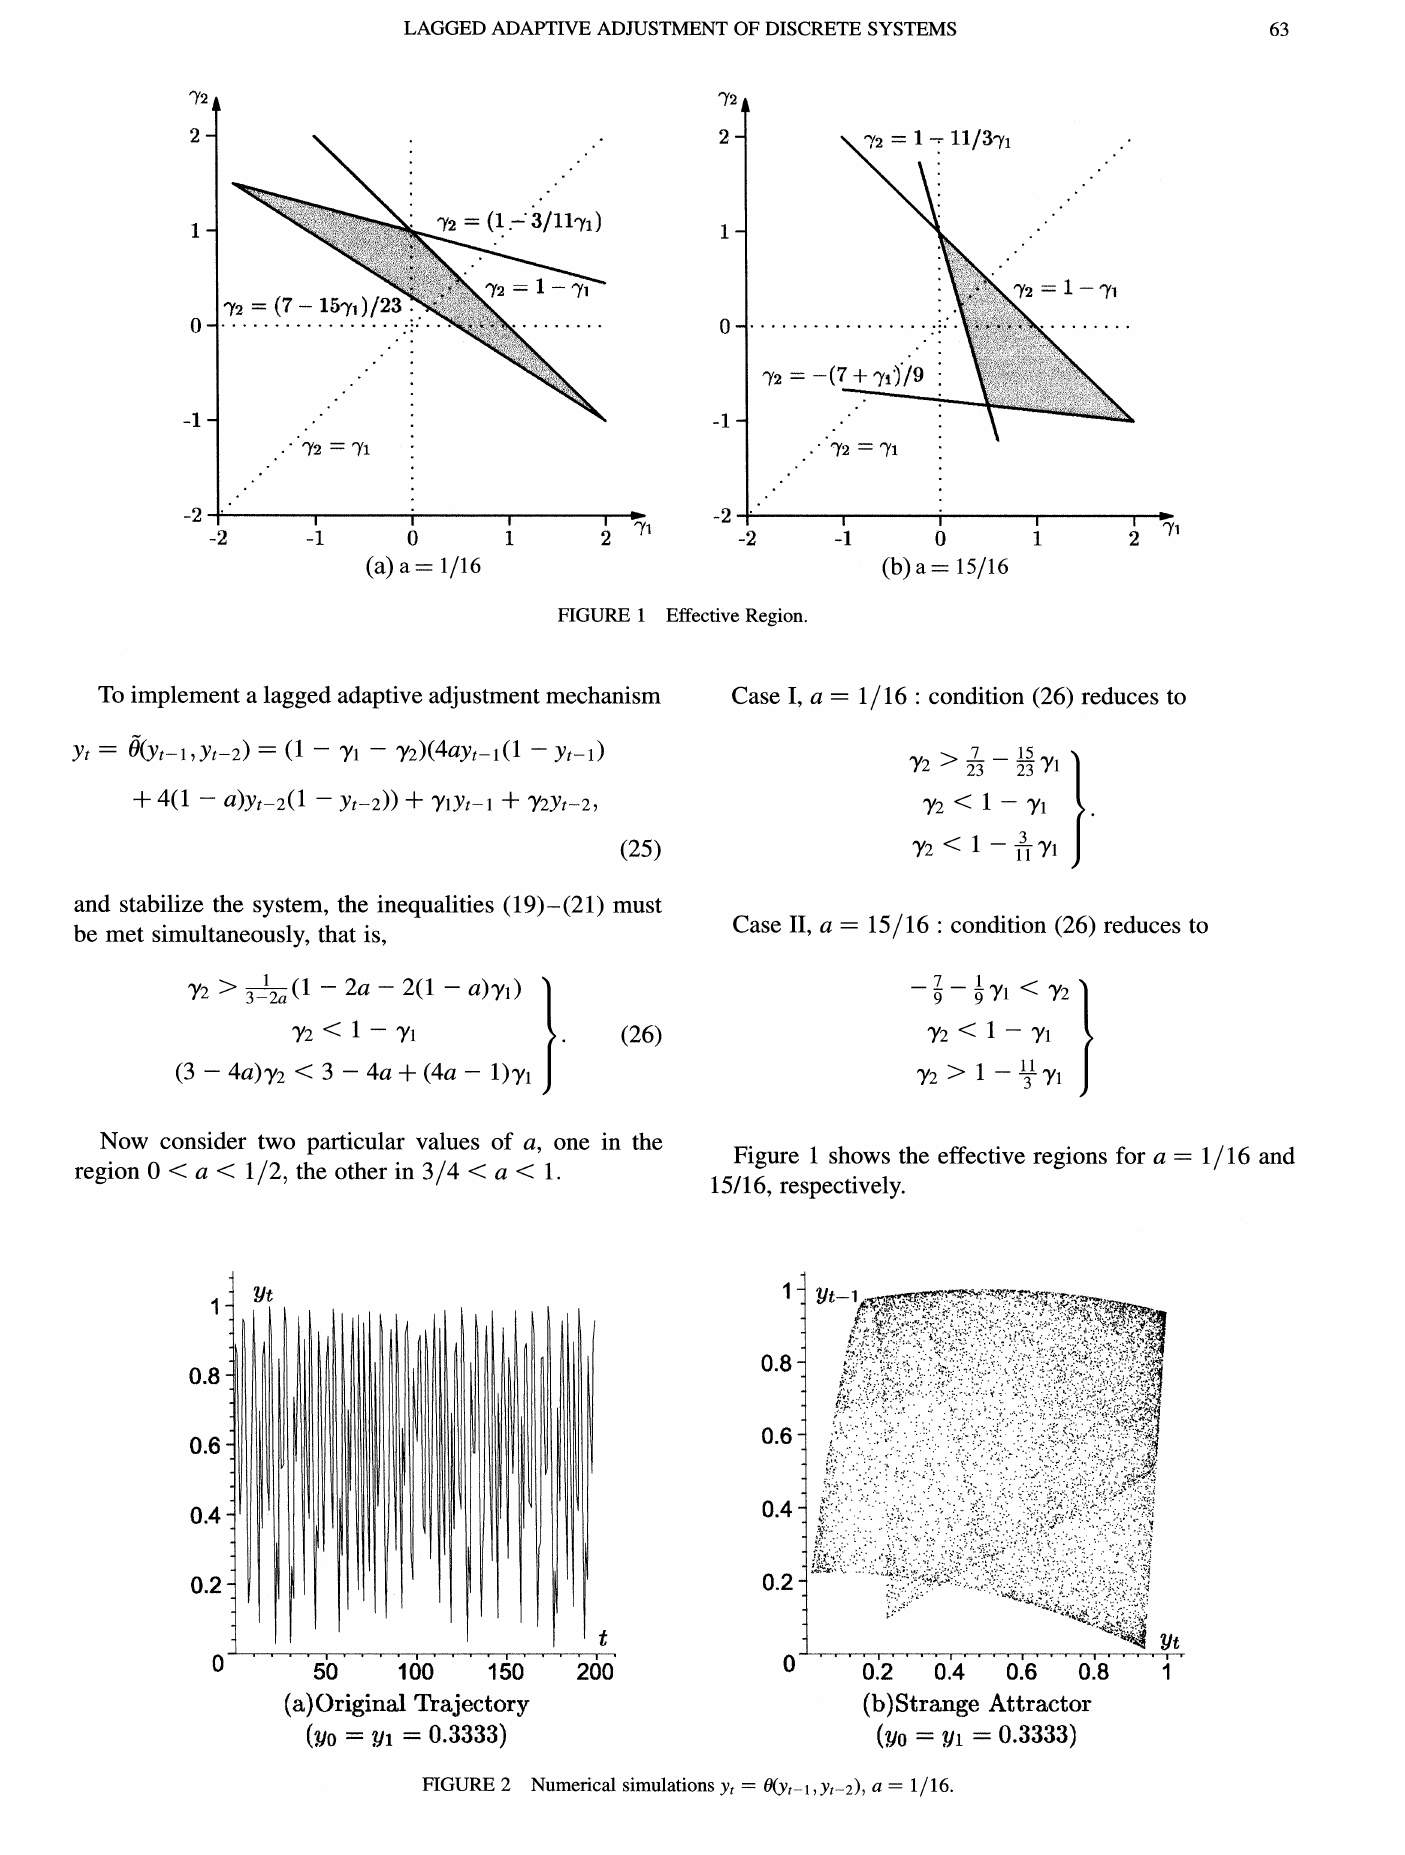
FIGURE 2 Numerical simulations y, O(,Yt-l,Yt-2), a